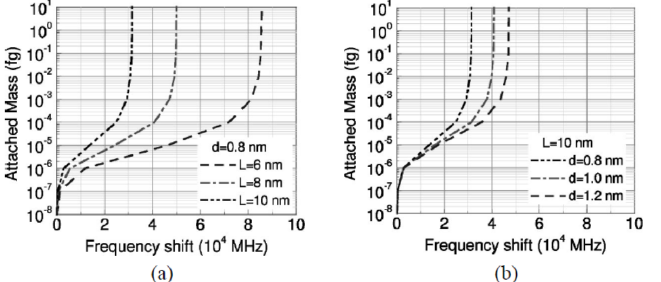
Figure 6. Frequency shift of cantilevered carbon nanotube resonators with ( a ) different lengths L or ( b ) different diameters d vs. attached mass. Adapted with permission for [126], copyright AIP Publishing,